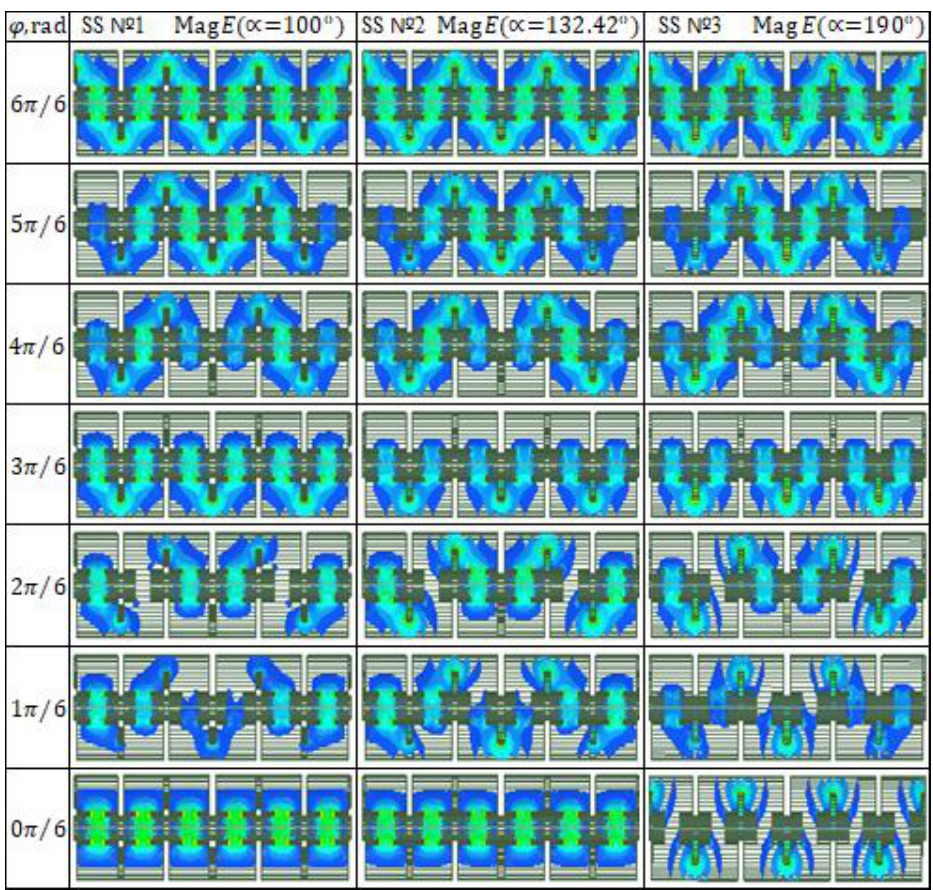
Fig. 4. The distribution of the electric field on the resonant modes of oscillation in the low-frequency passband SS